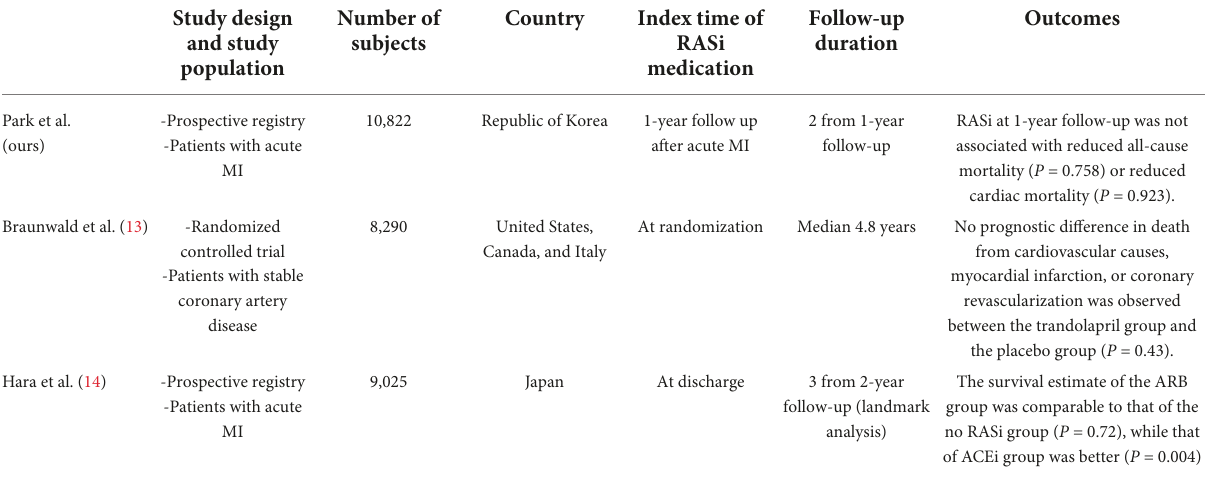
TABLE 2 Comparison of studies about the limited role of RASi